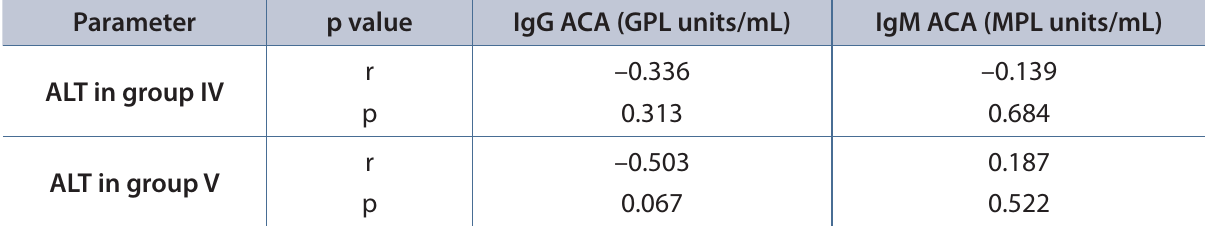
Table 6. Correlation between ALT level and ACA values